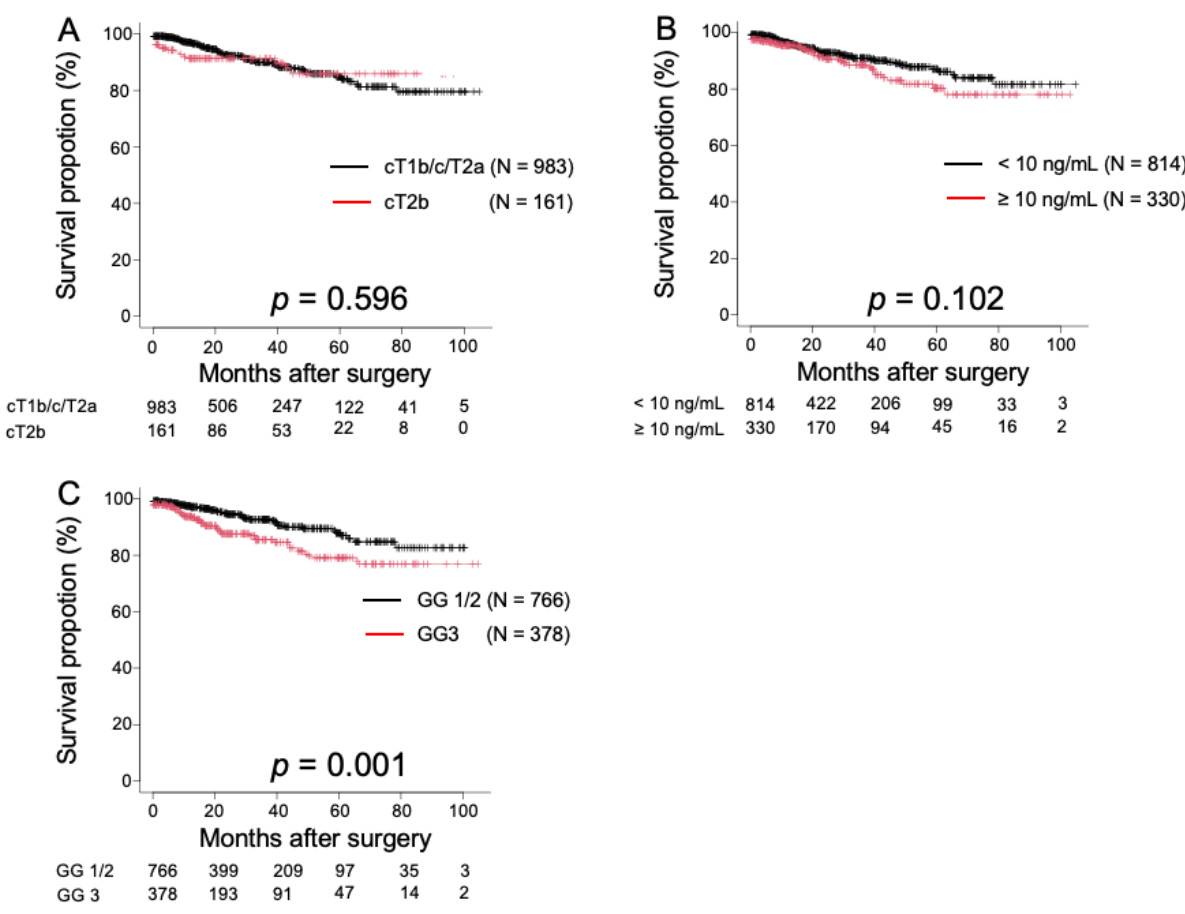
Table 2. Multivariate analysis.